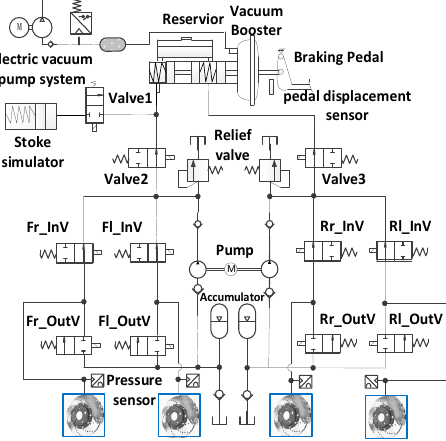
Figure 3. The hydraulic braking system (HBS) structure diagram.